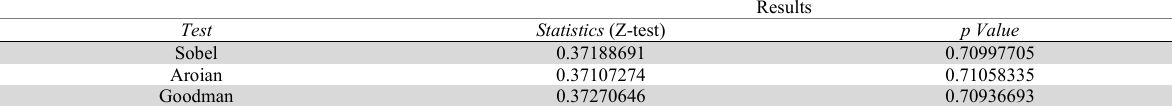
Sobel Test results for mediation of customer satisfaction on the relationship between Service Quality and Behavioral Inten-